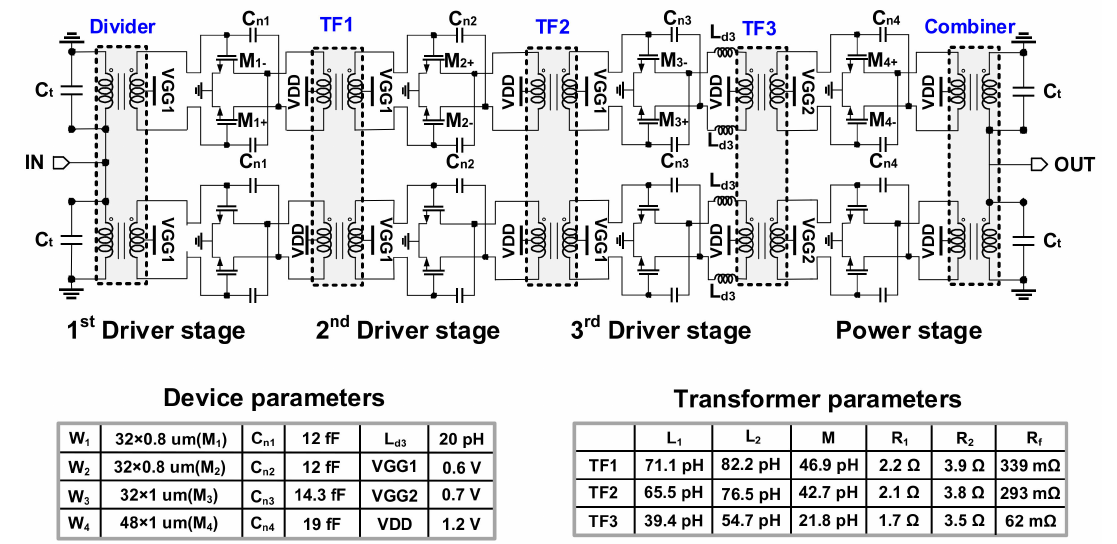
Figure 1. Schematic diagram of the 4-way transformer-based push-pull power amplifier used in the balanced 8-way PA.